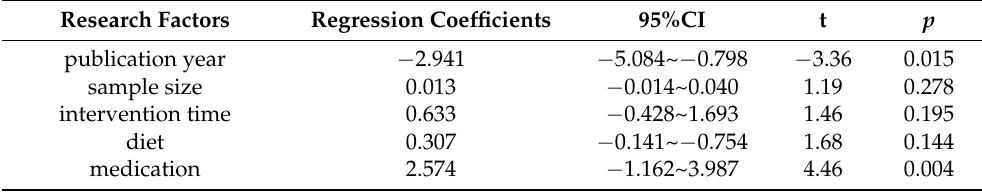
Table 7. Meta regression analysis of heterogeneous factors of